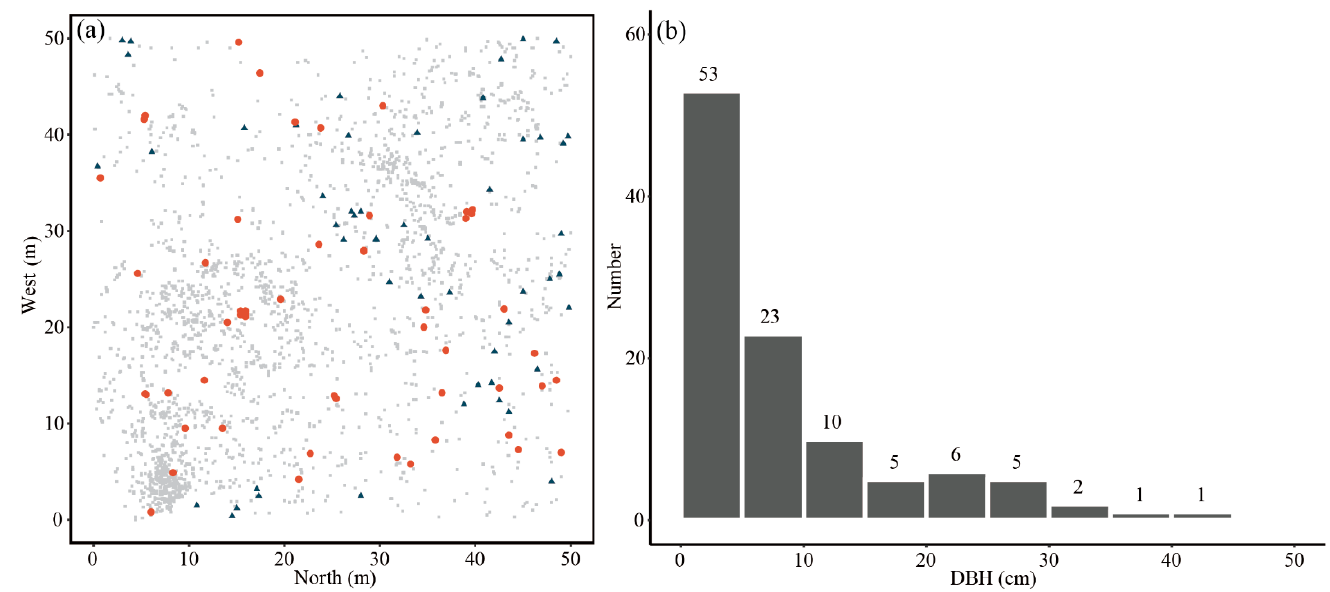
Figure 2. Spatial distribution of the sample plot ( a ), and diameter at breast height (DBH) structure of the Quercus wutaishanica ( b ). Trees, red circles; saplings, blue triangle; seedlings, gray rectangle.